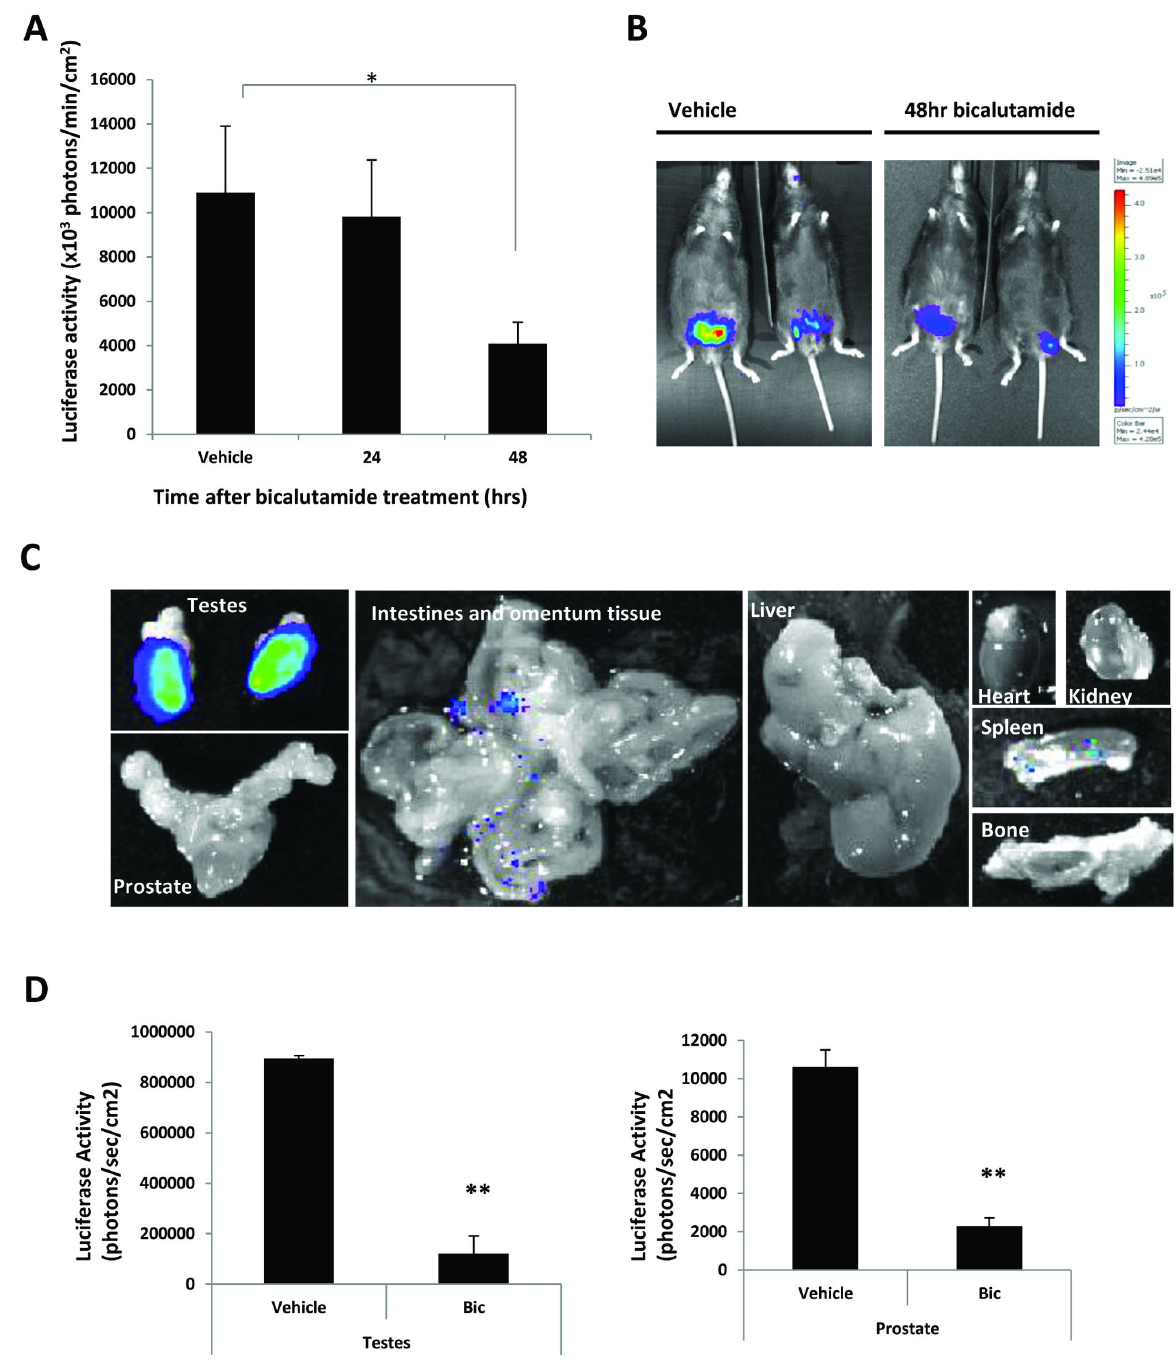
Figure 4. Bicalutamide treatment reduces androgen receptor activity in male mice. Bioluminescent imaging of male mice treated with bicalutamide (50mg/kg) for 24 and 48 hours. (A), Graph indicates measured bioluminescence signal from the gonadal region at the indicated timepoints; error bars represent the standard error from three mice in each group. (B), representative bioluminescent image of vehicle and bicalutamide treated mice at 48hours. Figure represents a greyscale photograph overlaid with a pseudocolour representation of bioluminescence; scale represents photons/sec/cm 2 . (C), panel showing ex vivo imaging of the organs from bicalutamide treated mice after 48hours (intestines image not to scale). (D), Bioluminescence signal from the testes and the prostate taken ex vivo, from male mice treated for 48hours with vehicle or bicalutamide. Error bars represent the standard error from three mice. **P<0.01, *P<0.05 (t-test analysis). doi: 10.1371/journal.pone.0071694.g004 PLOS ONE |